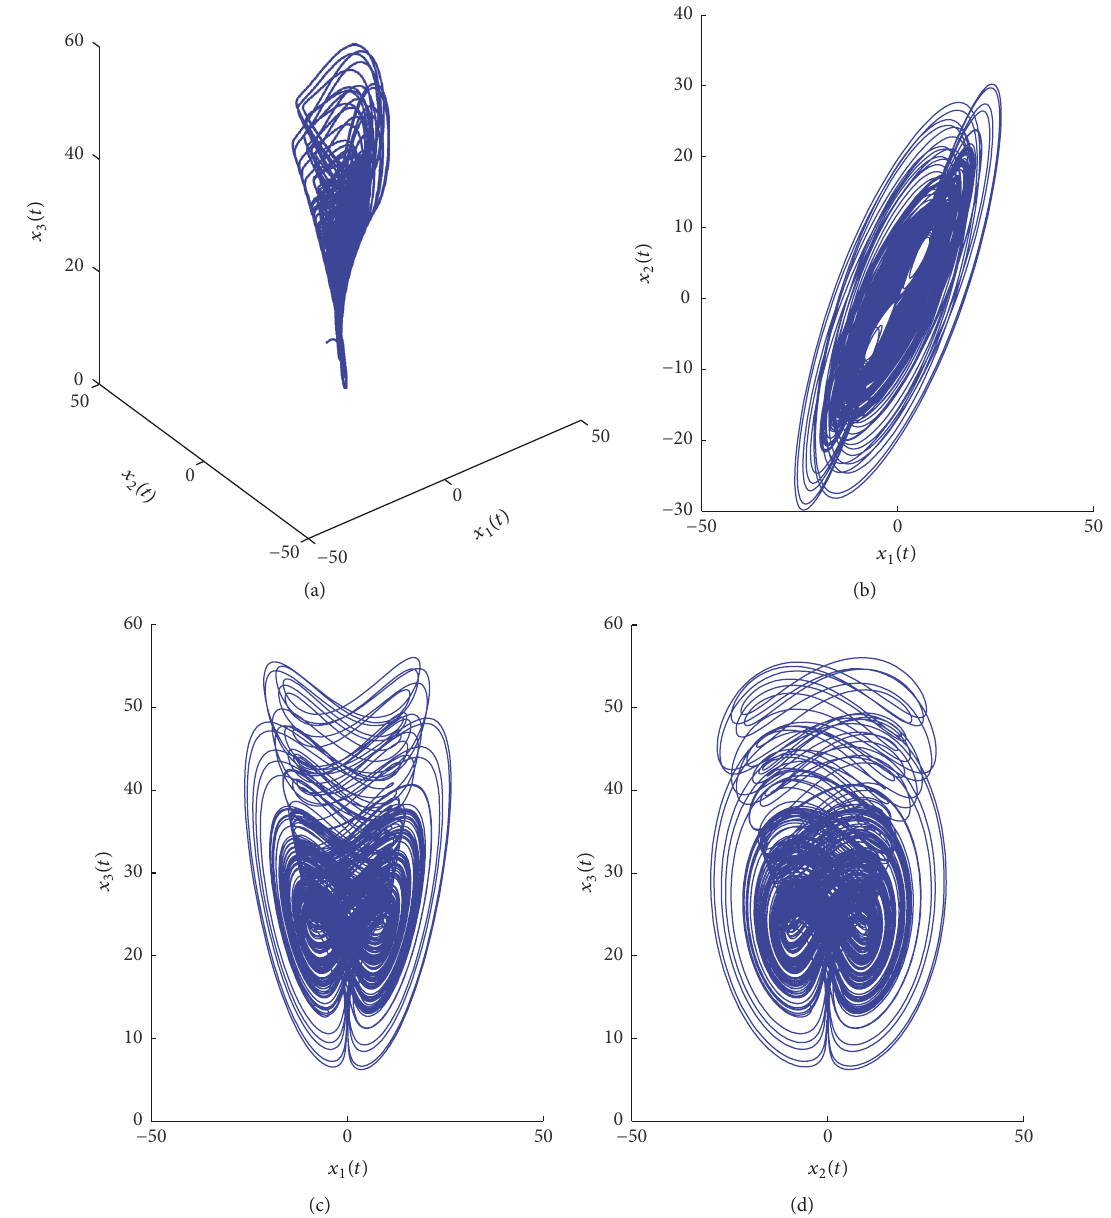
Figure 1: 3D and 2D chaotic attractors of Chen system